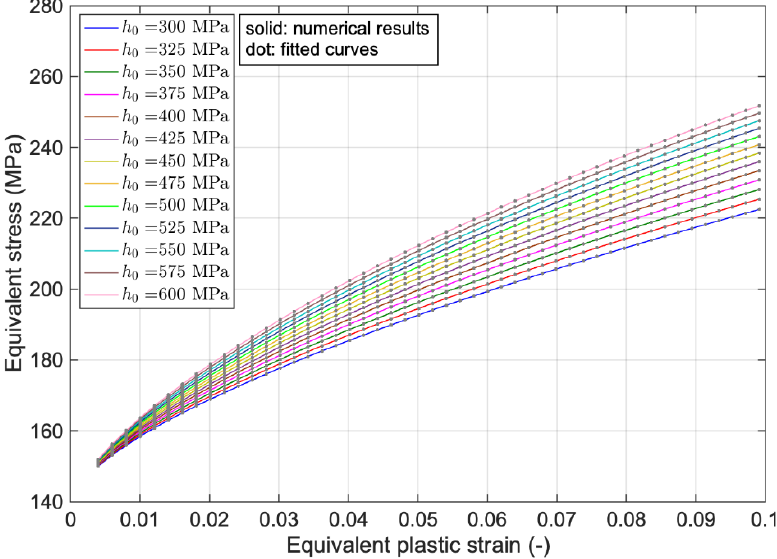
Figure 7. Comparison between numerical results and fitted curves with change in h 0 .